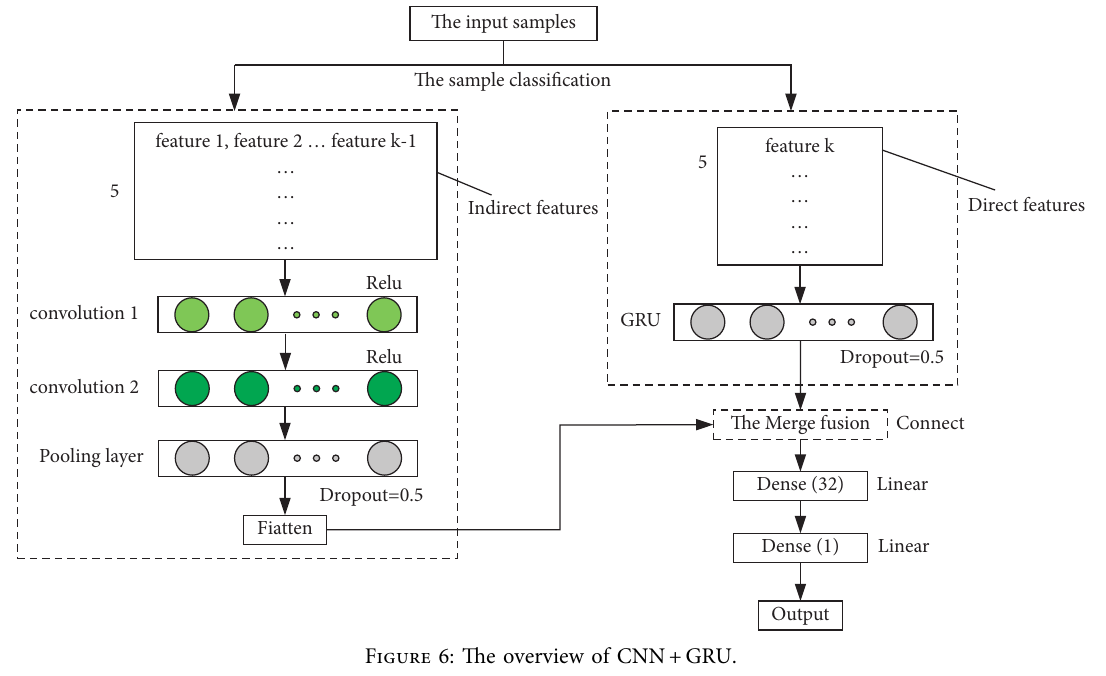
Figure 6: The overview of